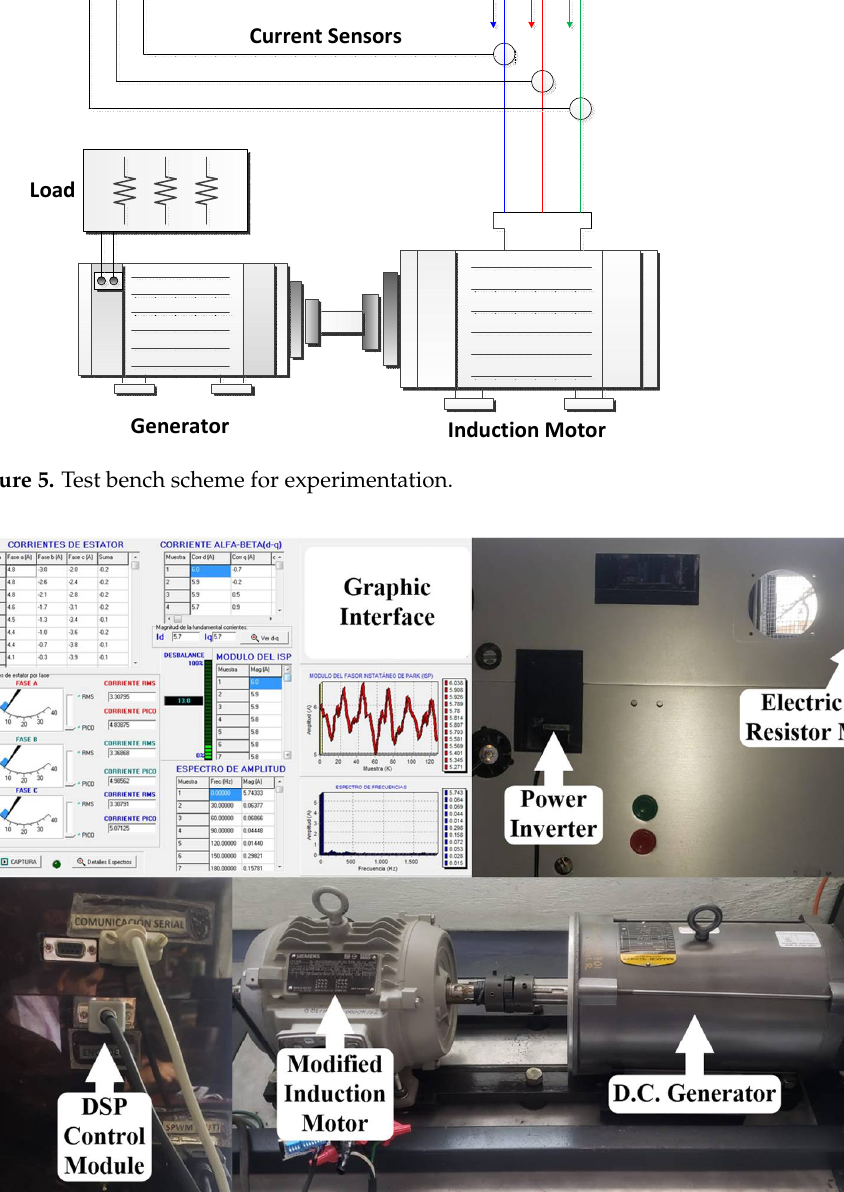
Figure 7. Phase currents from an induction motor in healthy condition. A m p li t u de ( A )